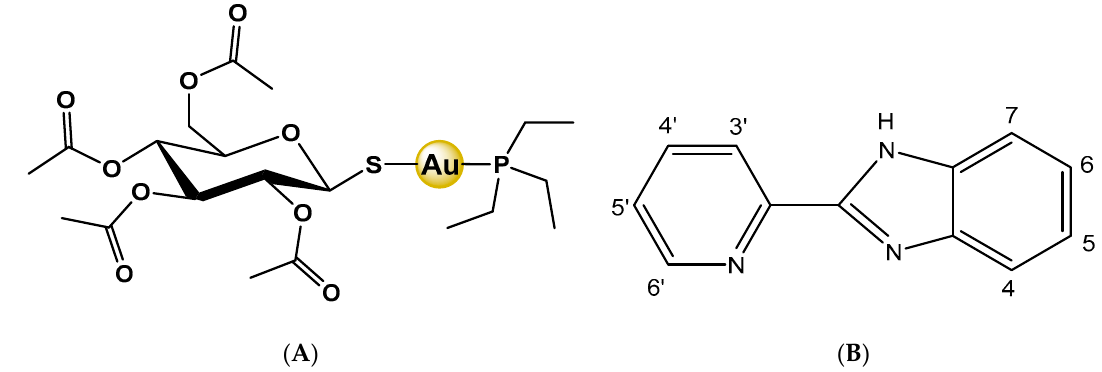
Scheme 1. ( A ) Auranofin: 2,3,4,6-tetra- O -acetyl- L -thio- β - D -glyco-pyranosato- S -(triethylphosphine) gold(I); ( B ) Number- ing scheme of 2-(2 ′ -pyridyl)benzimidazole (Hpben), which is the N-donor ligand used in this work to coordinate gold atom instead of the S-glycoside ligand of